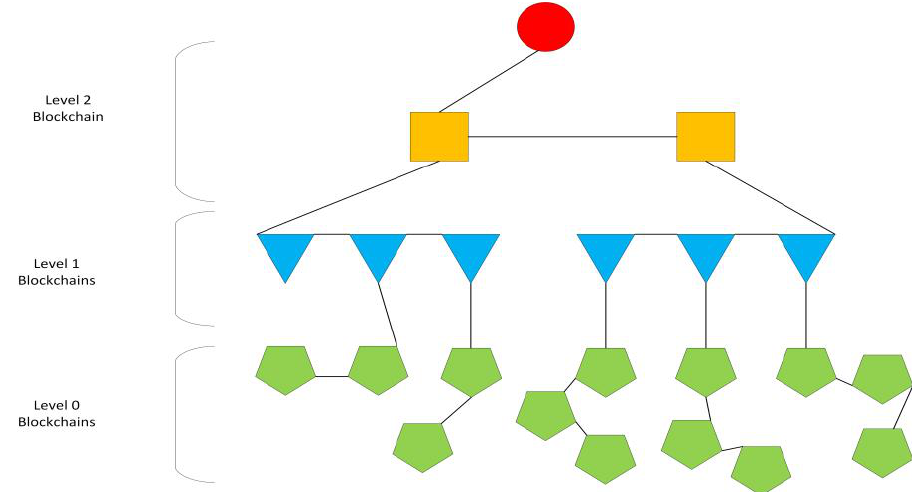
Figure 2. Devices clusters and blockchain levels relation.